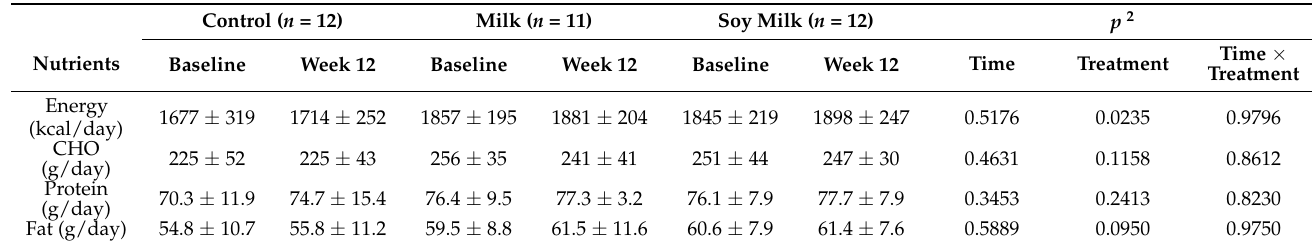
Table 5. Effects of milk or soy milk combined with resistance exercise on the dietary intake of very old nursing home residents with sarcopenia 1